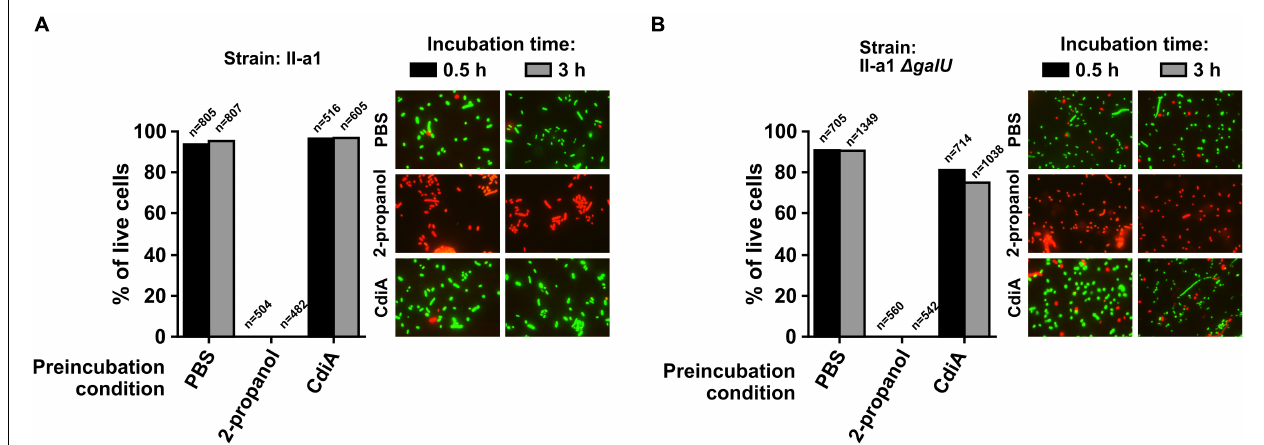
FIGURE 6 | Live/dead assays performed with A. baumannii clinical strain II-a1 (A) and its galU mutant (B) . Graphs display the percentage of live cells. Bacteria, before each assay, were treated for 30 min or 3 h with either PBS (live control), 2-propanol (dead control), or the purified CdiA. Treated bacteria were visualized at 1,000 × magnification with a fluorescence microscope Olympus AX70 equipped with 100 × /1.35 oil immersion lens and WIBA (460–490 nm for excitation and 515–550 nm for emission) and MWG (510–550/590) filter cubes for SYTO9 and propidium iodide, respectively. Representative images of stained cells from each live/dead assay are provided next to graphs. Displayed data are from two separate biological replicates with similar outcomes. Numbers above columns indicate total number of bacterial cells